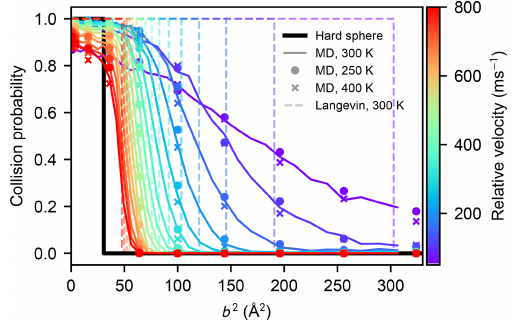
Figure B1. Collision probabilities of sulfuric acid molecules, as a function of the impact parameter squared, for different values of the relative velocity, obtained from molecular dynamics simulations at 300K (solid coloured lines), at 250K (coloured dots), and at 400K (coloured crosses). The step-like collision probabilities for a hard- sphere model ( b 2 = ( 2 R) 2 ), or those obtained from the Langevin capture model (Eq. 9), are indicated by the solid black, and dashed coloured lines, respectively.